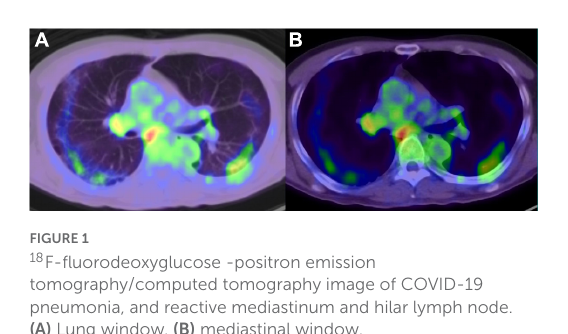
FIGURE1 18 F-fluorodeoxyglucose -positron emission tomography/computed tomography image of COVID-19 pneumonia, and reactive mediastinum and hilar lymph node. (A) Lung window, (B) mediastinal